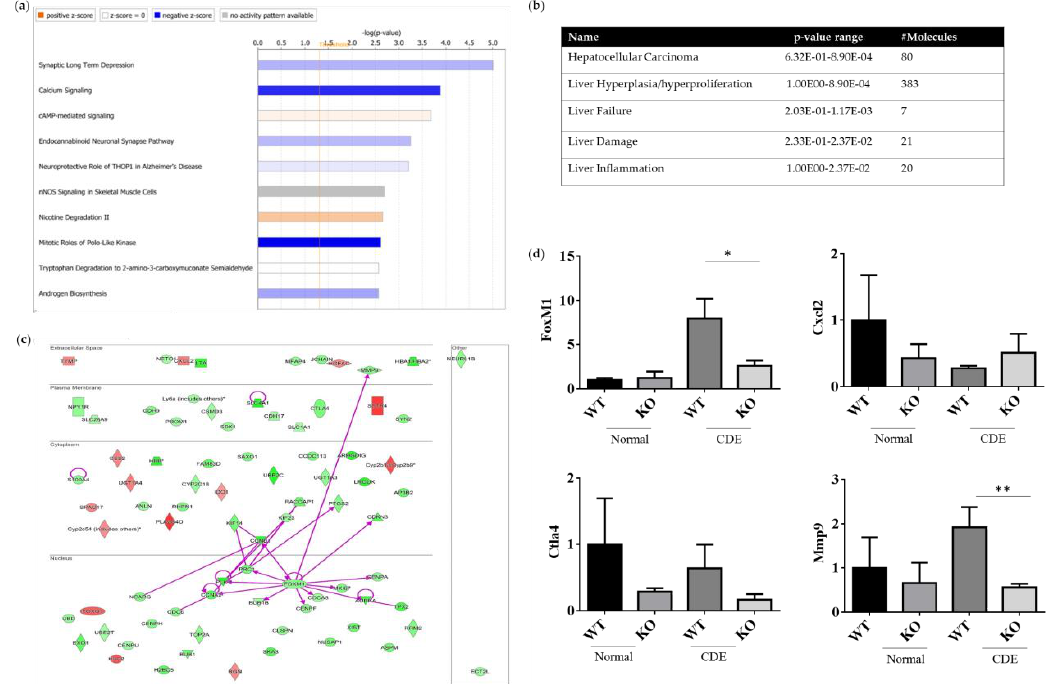
Figure 6. ERK2-regulated di ff erential expression genes (DEGs) in canonical signaling pathways. DEGs from WT and Erk2 − / − livers under the CDE diet treatment (each group, n = 5) were subjected to the analysis of canonical signaling pathways. ( a ) Top-10 enriched canonical signaling pathways identified by Ingenuity Pathway Analysis. Orange, activated; blue, inhibited; gray, no activity pattern available. (Positive z-score, activation; negative z-score, inhibition). ( b ) Erk2-dependent DEGs in hepatotoxicity. ( c ) 80 DEGs in HCC were represented in red (up-regulation) and green (down-regulation). The direct interactions were shown in purple solid arrows. Molecules are shown in their locations such as extracellular space, plasma membrane, cytoplasm, nucleus and other. ( d ) Gene expression of FoxM1, Cxcl2, Ctla4, and Mmp9 were determined by QPCR. Data were normalized by the average of gene expression level in WT under the normal chew diet (WT, normal) as 1. Data were represented as mean +/ − SE and were considered significant if * p < 0.05; ** p < 0.01. WT ( n = 4), KO ( n = 4).